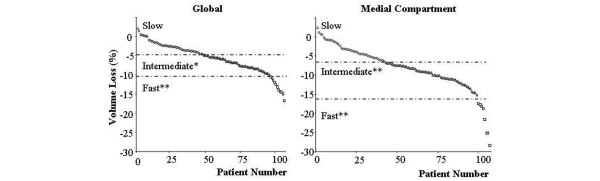
Changes in osteoarthritis cartilage volume percentage of loss from baseline after 24 months for each patient for the global knee and medial compartments of the three subgroups identified in the cluster analysis: slow (n = 48), intermediate (n = 48), and fast (n = 11) progressors. The global (and medial) volume loss at all the different time points were -2.3 ± 0.4% (-3.2 ± 0.6%) for the slow progressors, -7.2 ± 0.6% (-9.9 ± 0.1%) for the intermediate progressors, and -13.2 ± 0.4% (-21.5 ± 0.1%) for the fast progressors; the intermediate and fast progressor subgroups were found to be statistically significant when compared to baseline (t test). *p < 0. 001; **p < 0.0001.